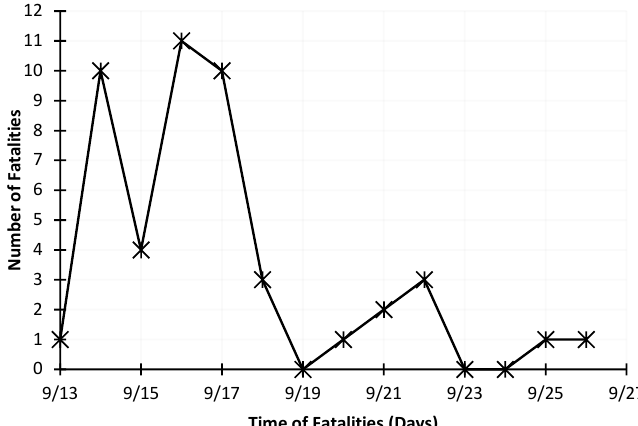
Figure 4. Temporal distribution of the fatalities caused by hurricane Florence in North Carolina.